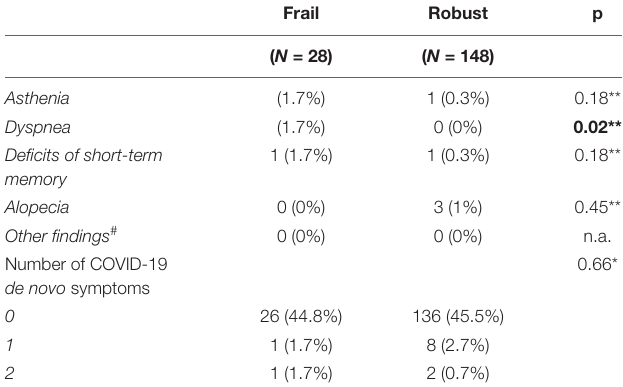
TABLE 4 | (Continued) Frail